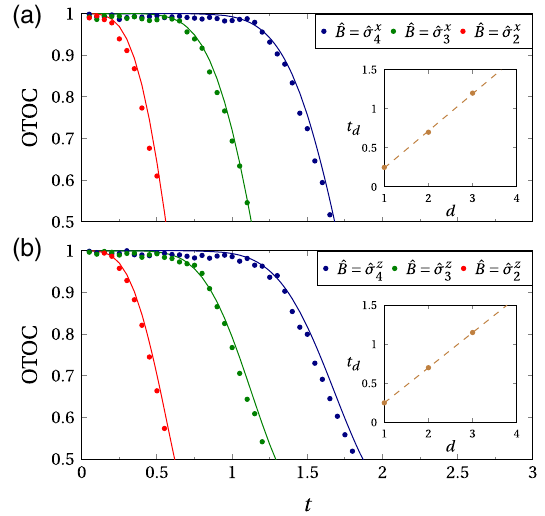
FIG. 4. Measurement of the butterfly velocity. (a) The OTOCs ˆ A ¼ ˆ σ z 1 and ˆ B ¼ ˆ σ x for , with i ¼ 4 (blue), i ¼ 3 (green), and i ˆ i ¼ 2 (red). (b) The OTOCs for A ¼ ˆ σ y 1 and ˆ B ¼ ˆ σ z , with i ¼ 4 i (blue), i ¼ 3 (green), and i ¼ 2 (red). The insets of (a) and (b) show the time for the onset of chaos t for the OTOCs versus d the distance between two operators. The slope gives 1 =v . Here, B g ¼ 1 . 05 and h ¼ 0 . 5